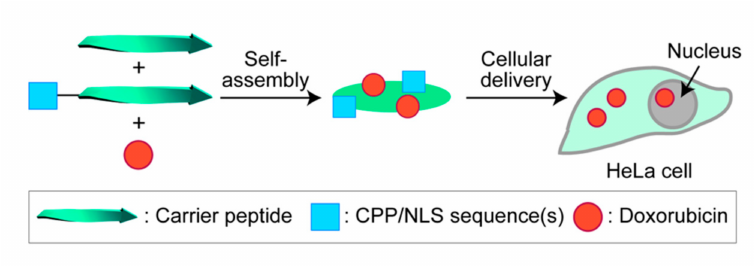
Figure 1. Schematic illustration of intracellular delivery of doxorubicin by modularized peptide assemblies as